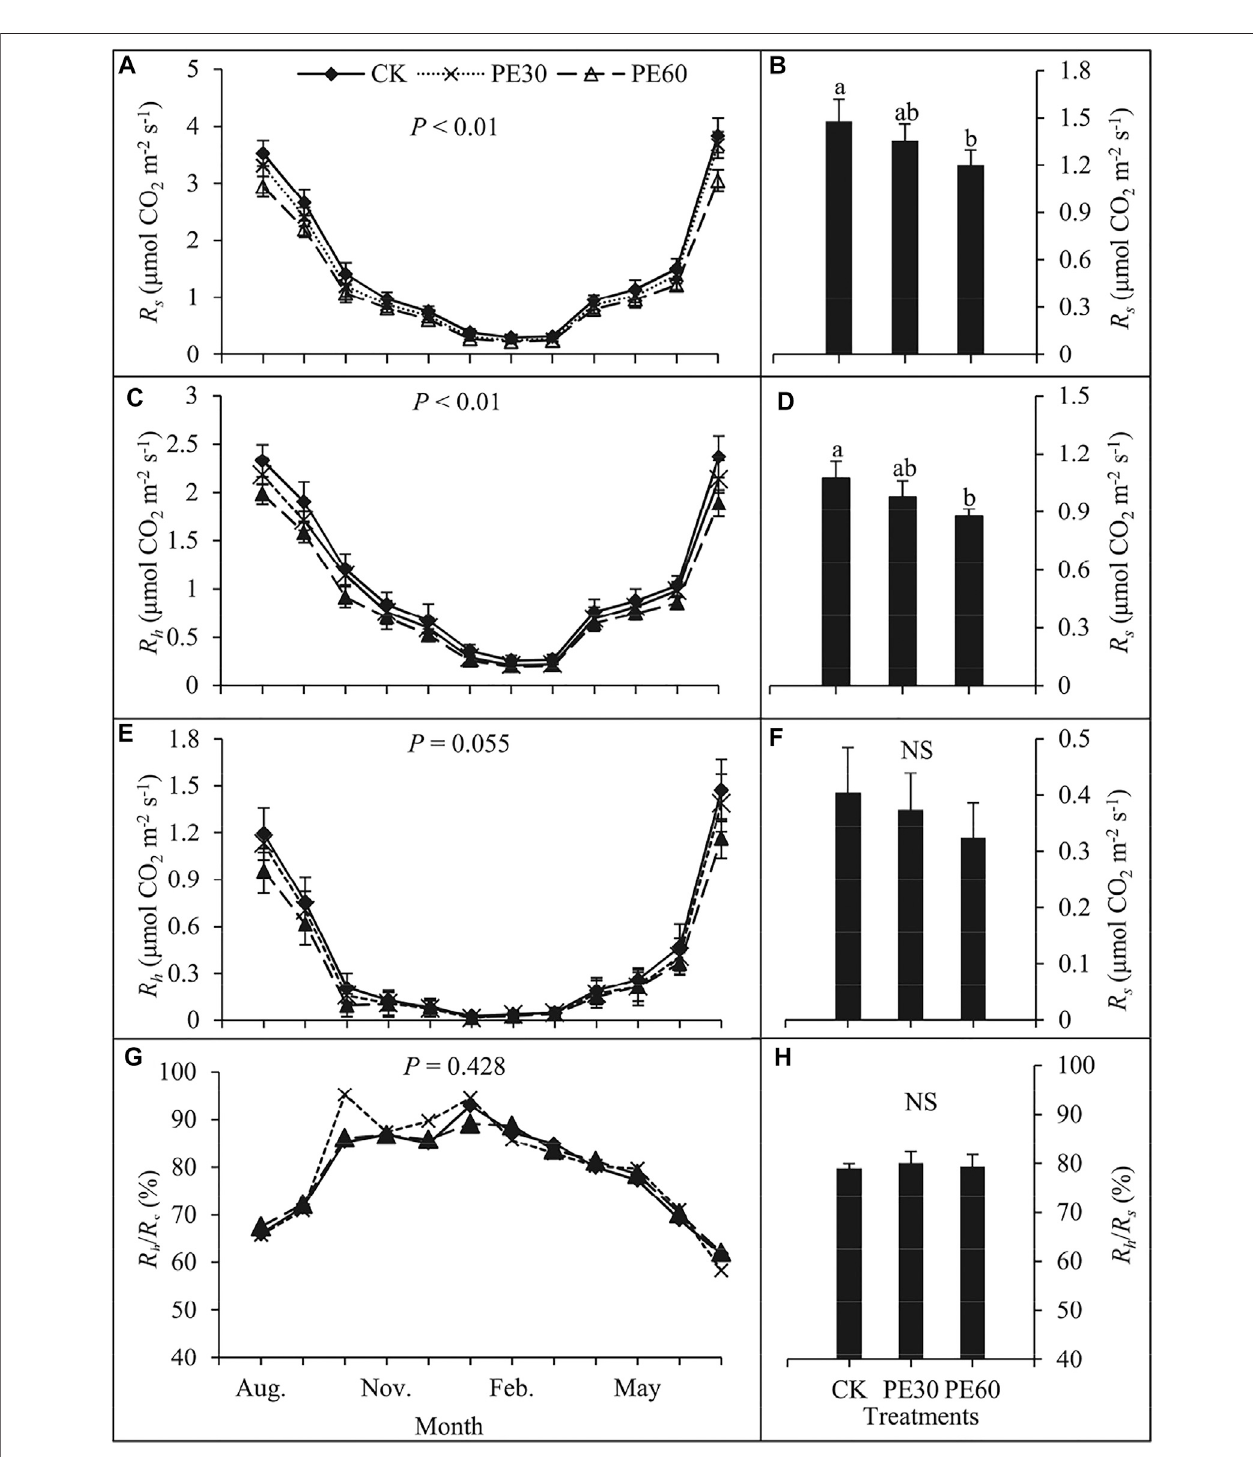
FIGURE3| Seasonalvariationsin (A) totalsoilrespiration( R s )andits (C) heterotrophic( R h )and (E) autotrophic( R a )componentsand (G) theratioof R h / R s (%)from August2016toJuly2017.Dataarethemean ± SD( n (cid:2) 3).Monthlymeanvaluesof (B) R s , (D) R h , (F) R a and (H) ratioof R h / R s (%)throughoutthestudyperiod.Letterson thetopofthebarsindicatesigni fi cantdifferenceamongtreatmentsatlevelof p < 0.05.CK:ambientprecipitation;PE30:30%reducedprecipitation;PE60:60%reduced precipitation.